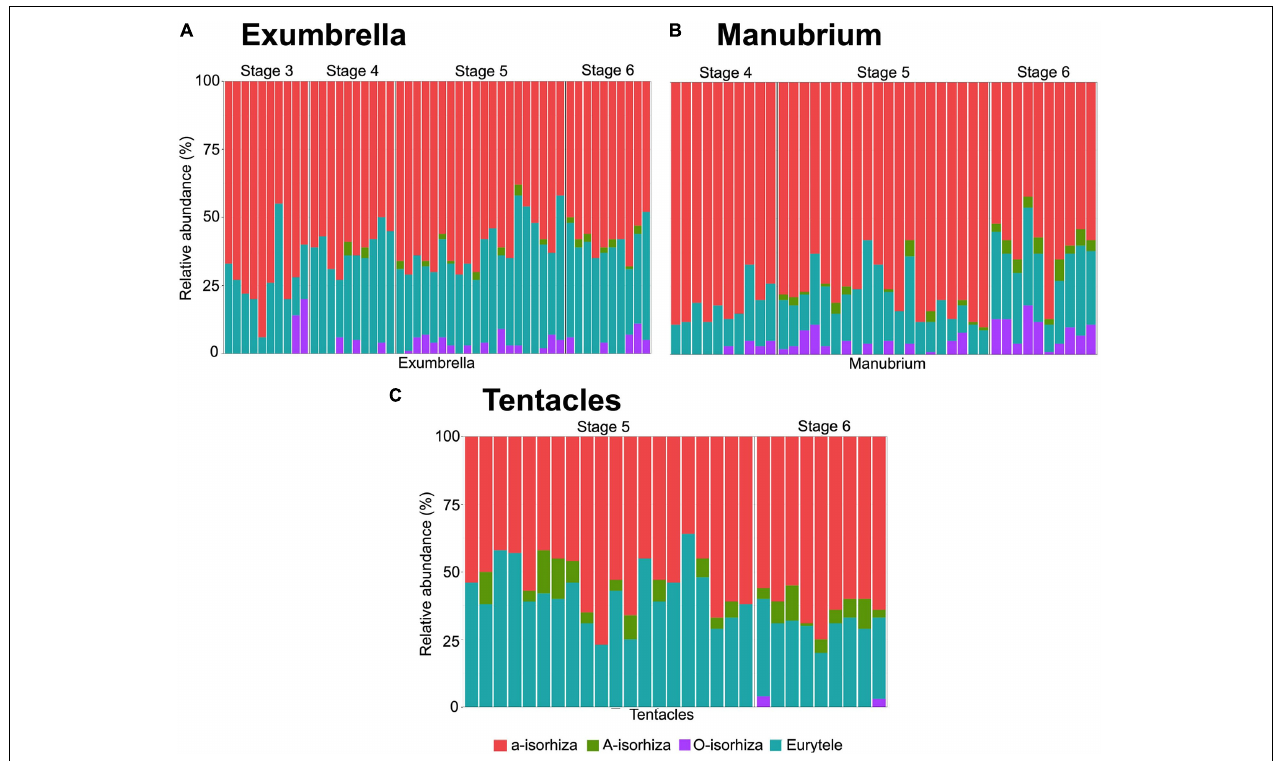
FIGURE 5 | Relative abundance of nematocyst types in batteries of different Pelagia noctiluca stages. (A) Exumbrella (50 batteries) (B) Manubrium (40 batteries). (C) Tentacles (30 batteries). Note large proportion of a-isorhizas and euryteles, and absence or very low proportion of A-isorhizas and O-isorhizas. Stages: metaephyra, stage 3; metaephyra, stage 4; juvenile medusa, stage 5; adult medusa, stage 6. Note: Gastric filaments not included due to the absence of nematocyst clusters.